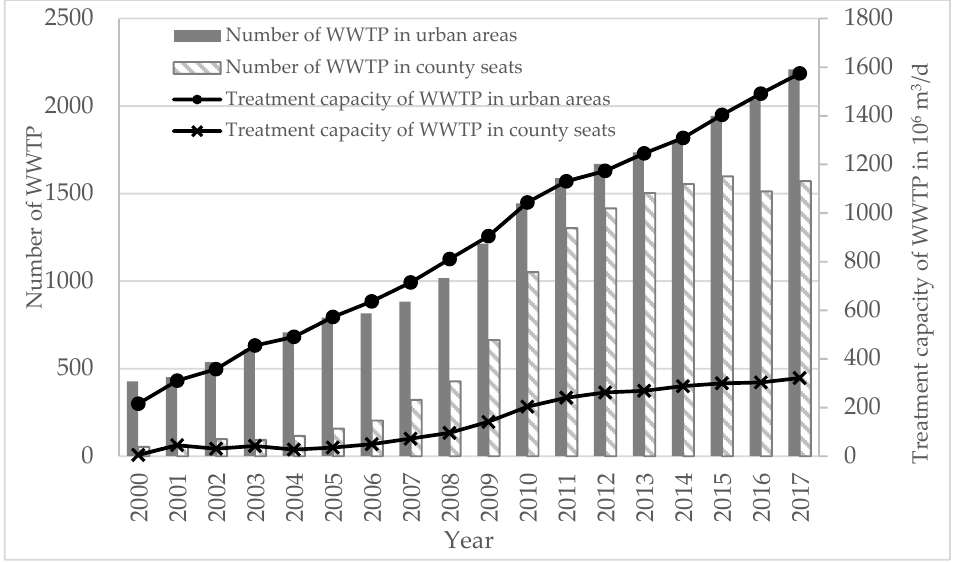
Figure 2. Development of wastewater treatment plants and treatment capacity in China (elaborated with data from [28].)